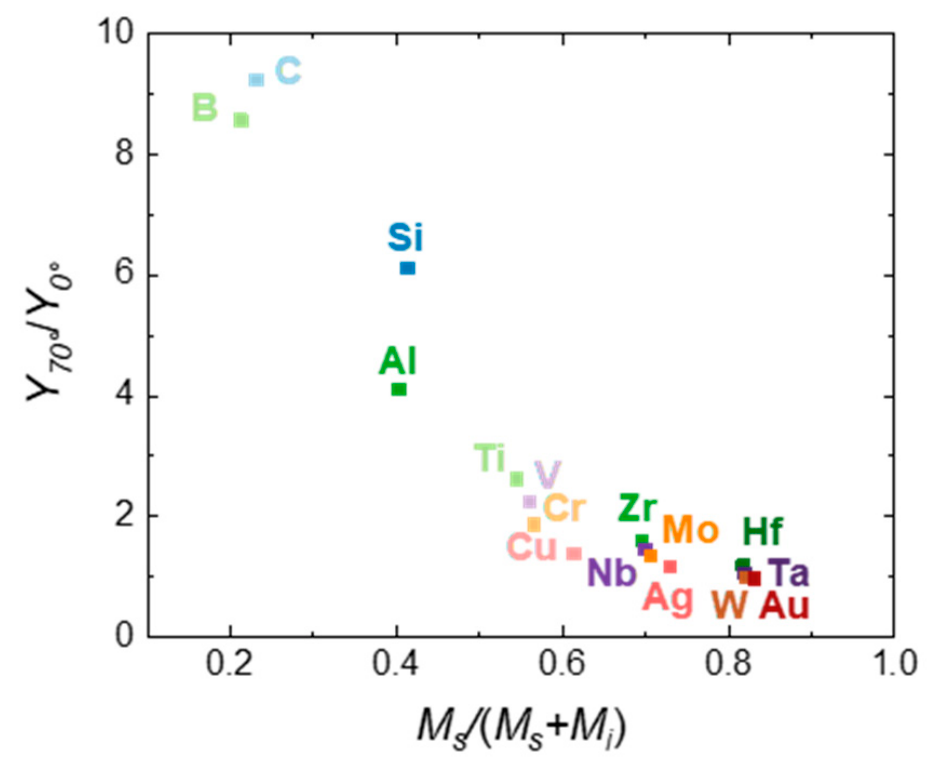
Figure 13. The sputtering yield at 70 ◦ argon ion incidence normalized by the perpendicular sputtering yield in dependence of the M s /( M s + M i )